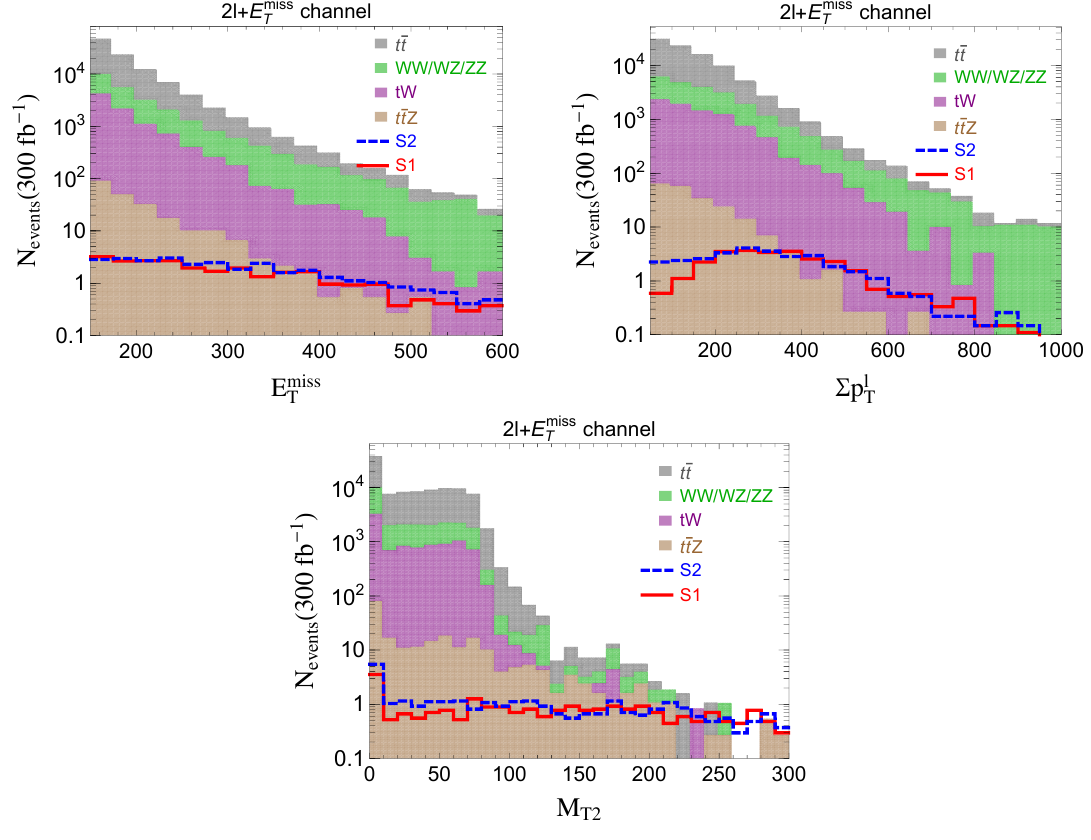
Figure 3 . Distributions of E miss